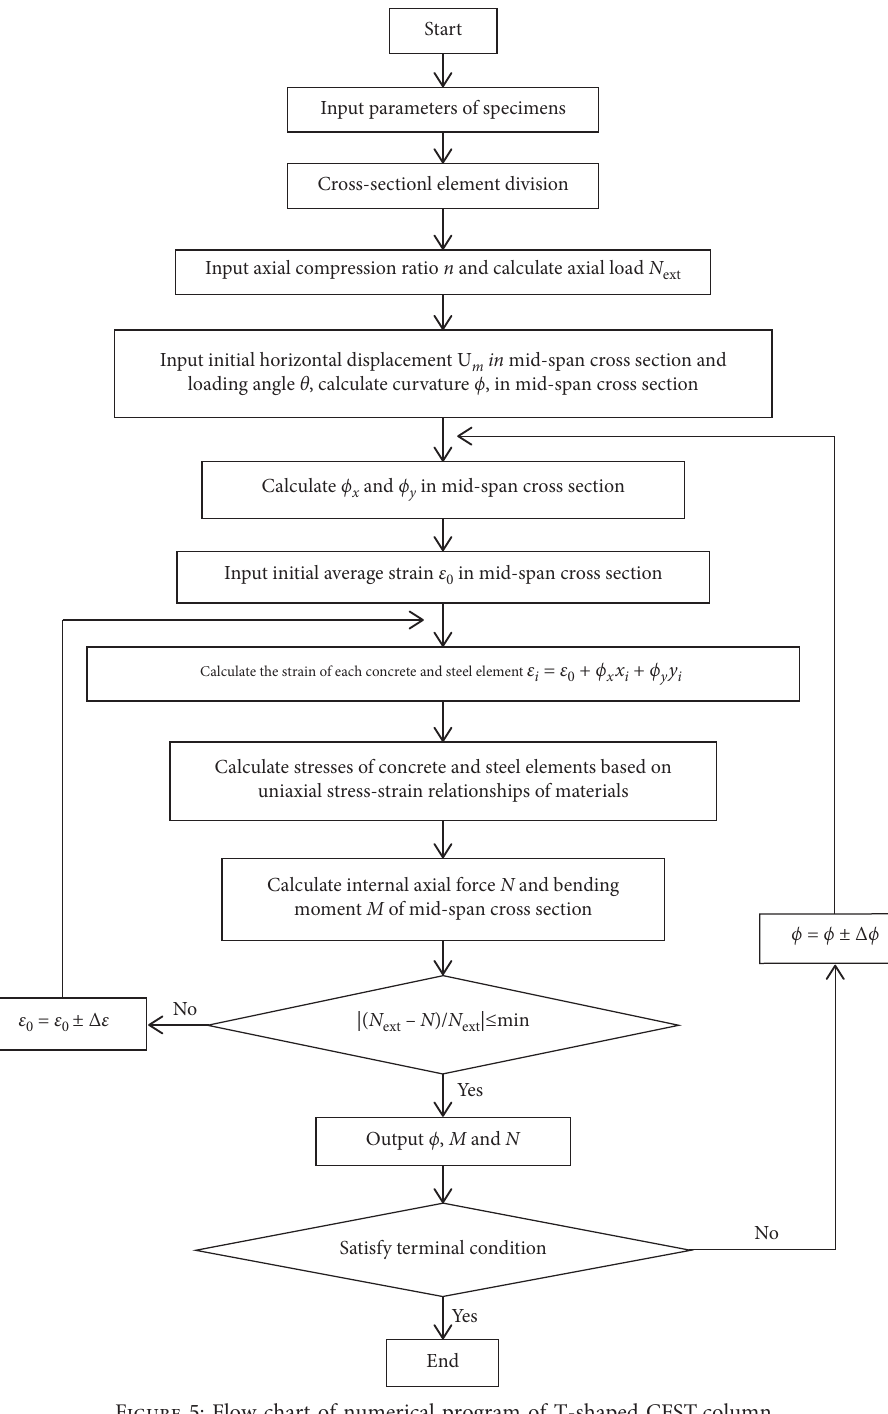
Figure 5: Flow chart of numerical program of T-shaped CFST